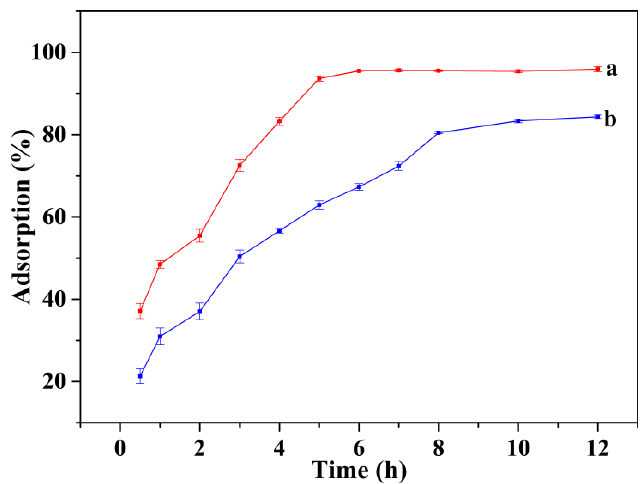
Figure 5. Effect of contact time on Pb 2+ adsorption of the Alg-Mel. (~100 mg ( a ) and ~20 mg ( b ) of Alg-Mel was equilibrated with 40 mL of 0.48 mM Pb 2+ at pH 5.0 and 25 °C, respectively).